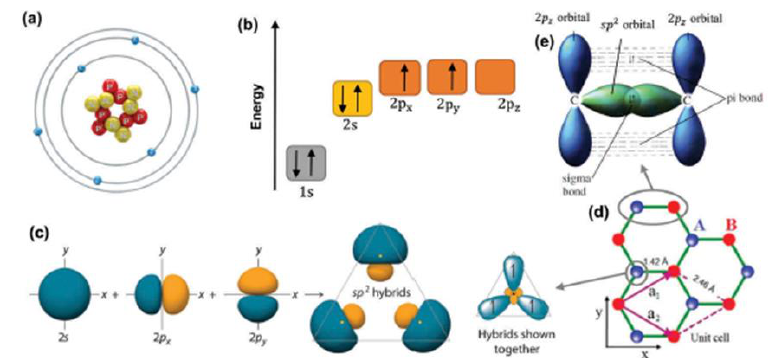
Figure 2. ( a ). Atomic structure of a carbon atom. ( b ) Energy levels of outer electrons in carbon atoms. ( c ) The formation of sp 2 hybrids. ( d ) The crystal lattice of graphene, where A and B are carbon atoms belonging to different sub−lattices, a1 and a2 are unit−cell vectors. ( e ) Sigma bond and pi bond formed by sp 2 hybridization [29] Copyright Science and technology of advanced materials, 2018.